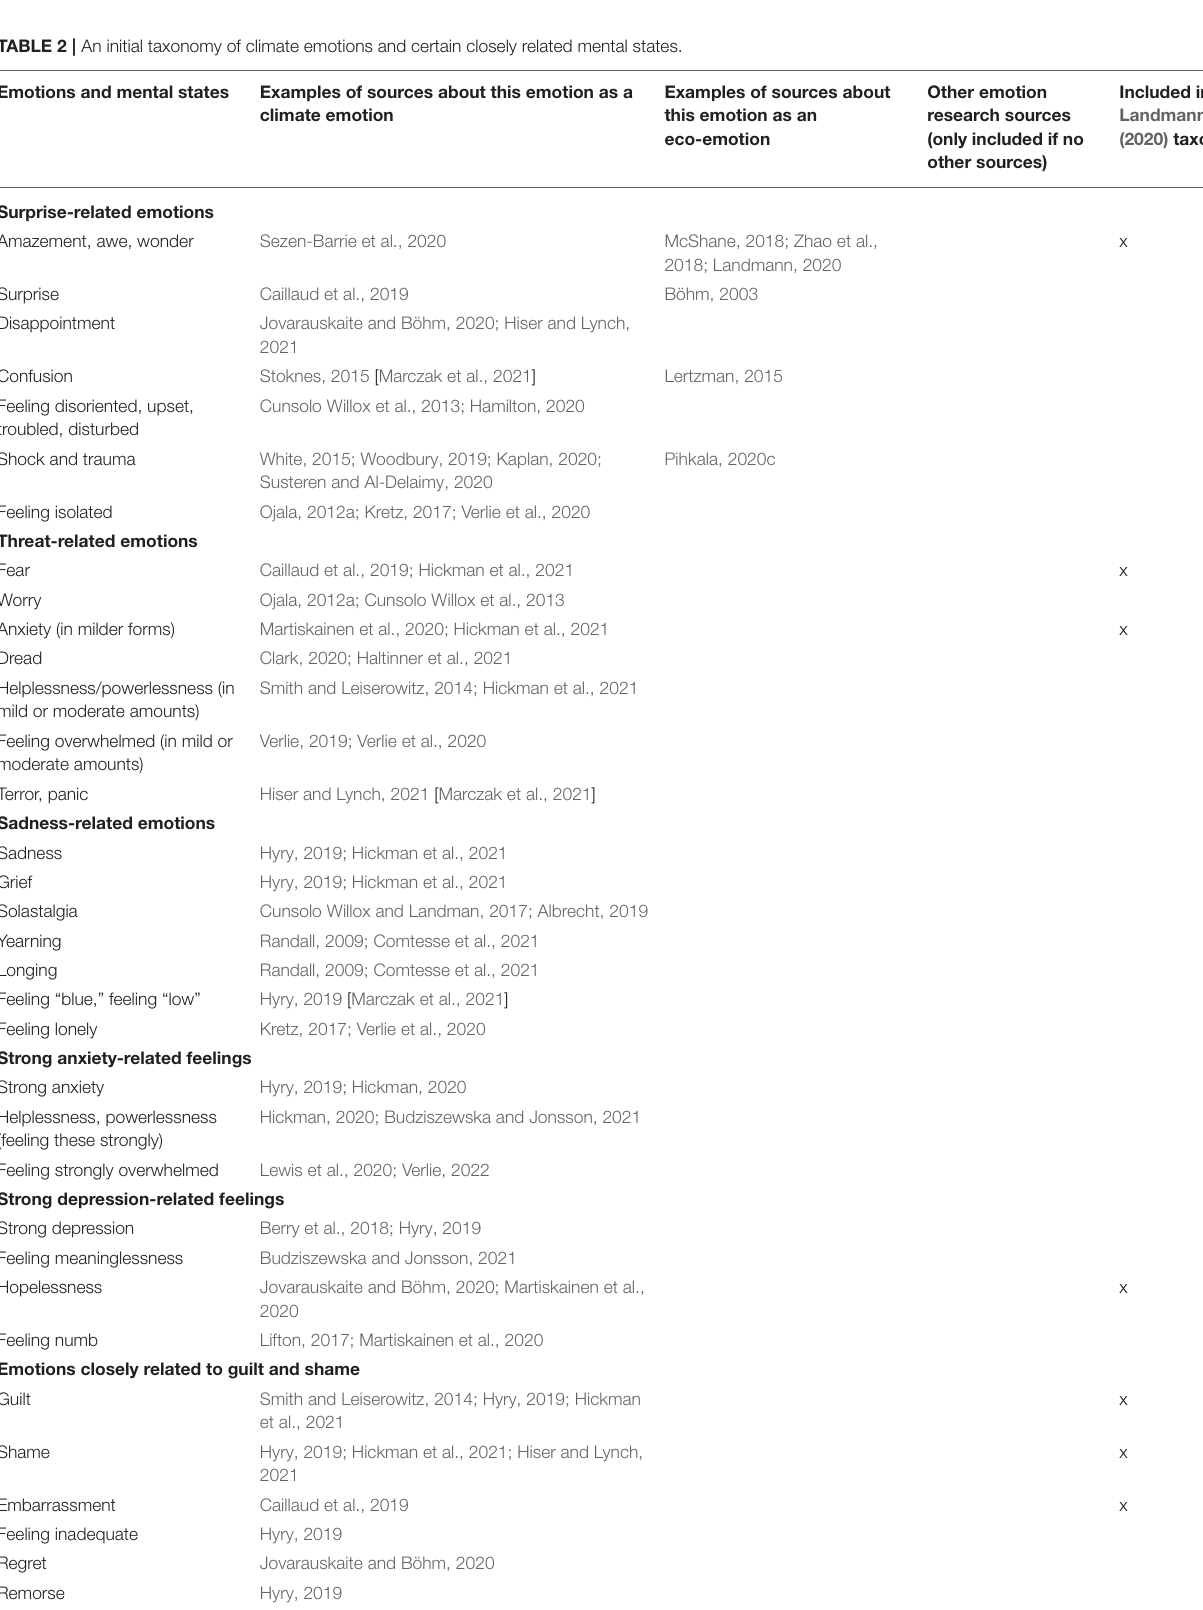
TABLE 2 | An initial taxonomy of climate emotions and certain closely related mental